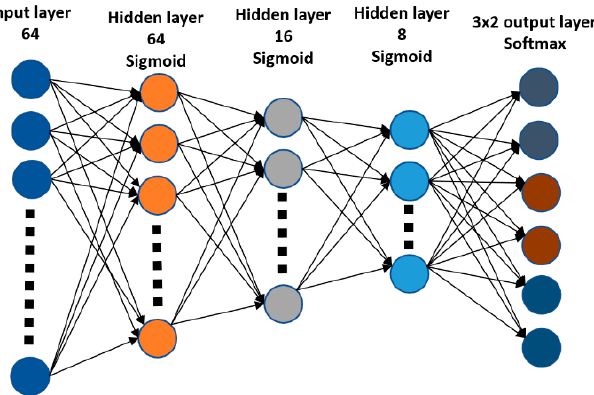
Figure 13. Deep Neural Network (DNN) architecture for covert channel demodulation.